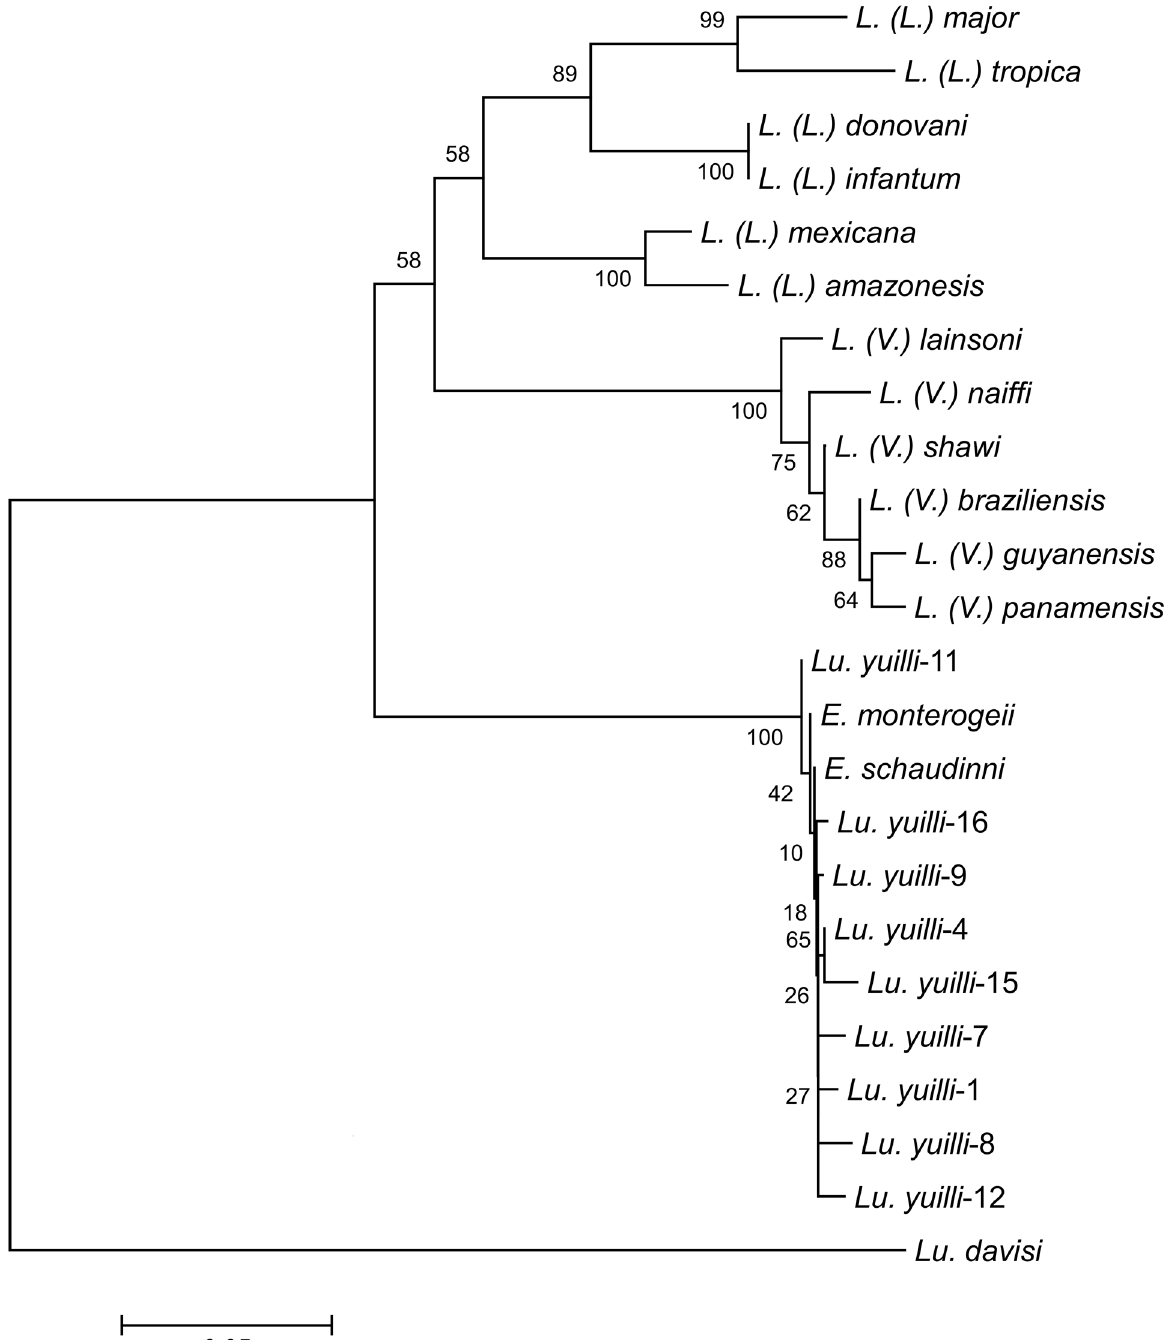
Fig 2. Phylogenetic tree of cyt b gene sequences among species. Leishmanial cyt b genes were amplified and sequenced from flagellates-positive sand flies, Lutzomyia (Lu . ) yuilli yuilli (1, 4, 7, 8, 9, 11, 12, 15, and 16) and Lu . davisi , and a phylogenetic analysis of cyt b gene sequences was performed by the neighbor-joining method together with sequences from 12 Leishmania and 2 Endotrypanum species. The scale bar represents 0.05% divergence. Bootstrap values are shown above or below branches.